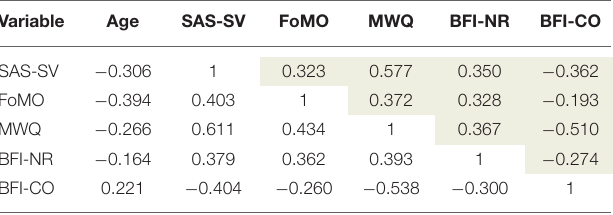
TABLE 2 | Zero-order bivariate Pearson’s and partial Pearson’s correlation coefficients representing associations between age and primary study variables among each other ( N =